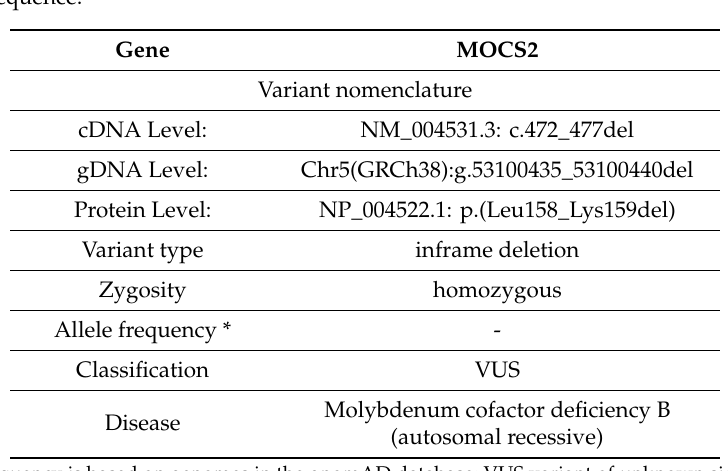
Table 2. Genetic result of our patient. Nomenclature of the variant following the guidelines of the as a protein